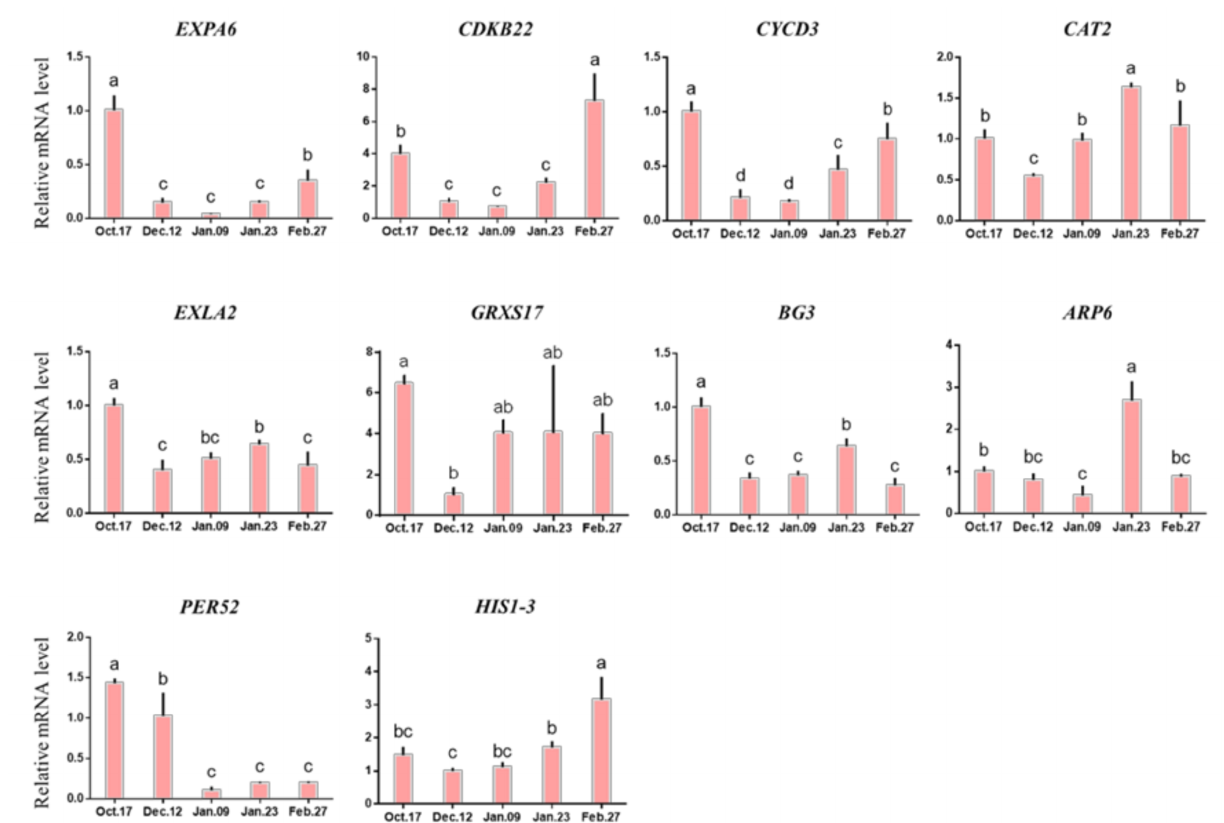
Figure 9. Change in the expression levels of antioxidant metabolism-related genes. Each bar represents the mean ± SEM ( n = 3). Different letters indicate a significant difference among different dates ( p < 0.05). The picture was drawn by GraphPad Prism 8.0 and the data were processed by IBM SPSS Statistics